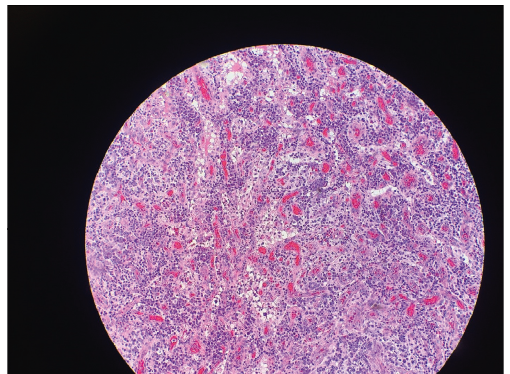
Figure 2: Histological appearance of axillary lymph node showing HHV-8 associated multicentric Castleman disease with plasma- blastic aggregates and Kaposi sarcoma on CD 138